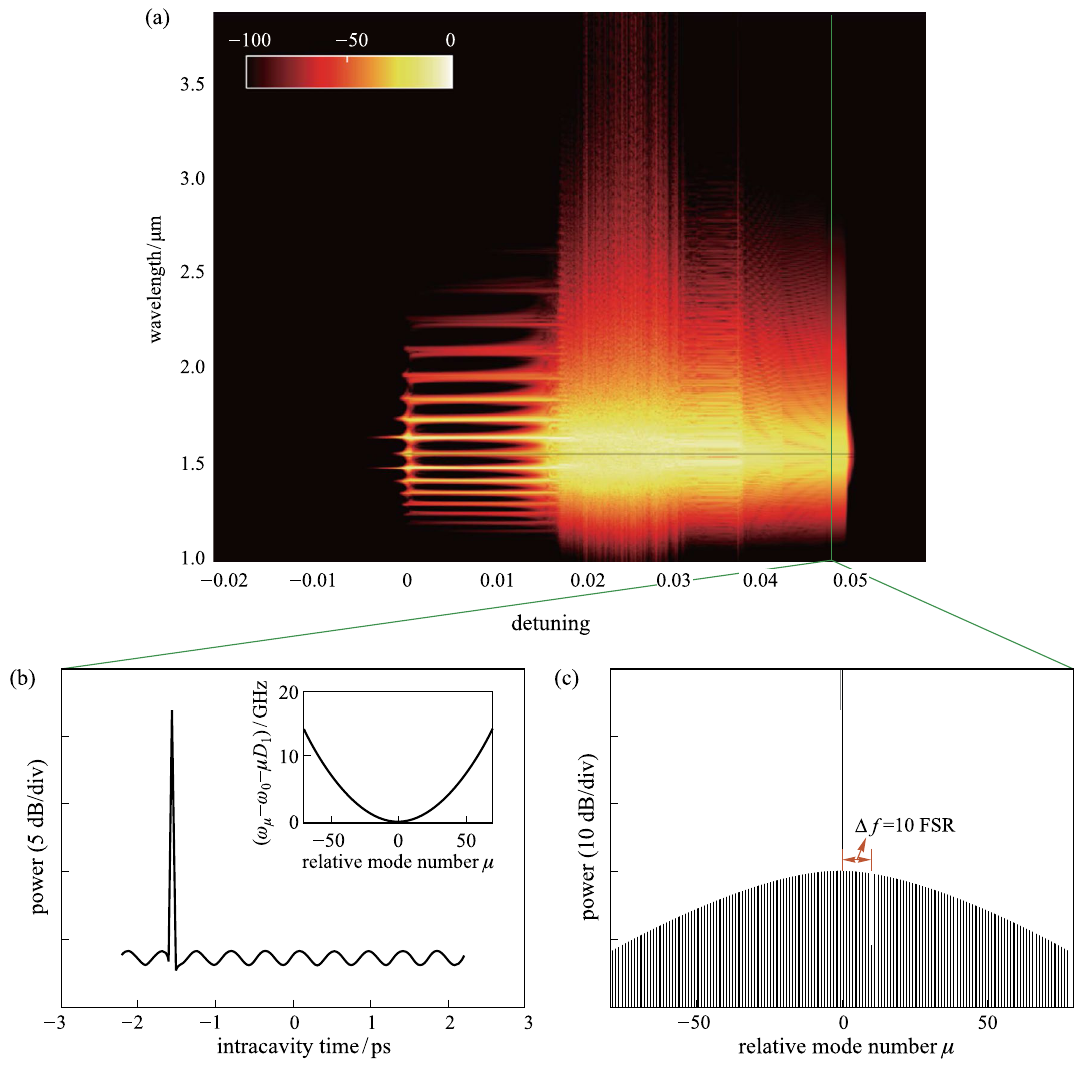
Fig. 2 Simulation results of the optical frequency combs with SMD in the micro-ring resonator. a Evolution of the comb spectrum with the change of detuning. The comb was initially generated with a pump wavelength of 1550 nm and 𝛿 being tuned from − 0.022 to 0.058. b and c Illustrate the simulated temporal soliton and spectrum when 𝛿 is tuned to 0.0491. Simulation parameters are t R = 4.4 ps , FSR = 226 GHz , L = 628 μm , 𝛼 = 9 × 10 − 3 , 𝜅 = 9 × 10 − 3 , 𝛽 2 = − 20 ps 2 ∕km , 𝛾 = 1 (W ⋅ m) − 1 , in 6 of 10 − per round-trip. The parameters of the coupled filter are g = 0.15 , 𝜇 = 10 , 𝜎 f = cavity